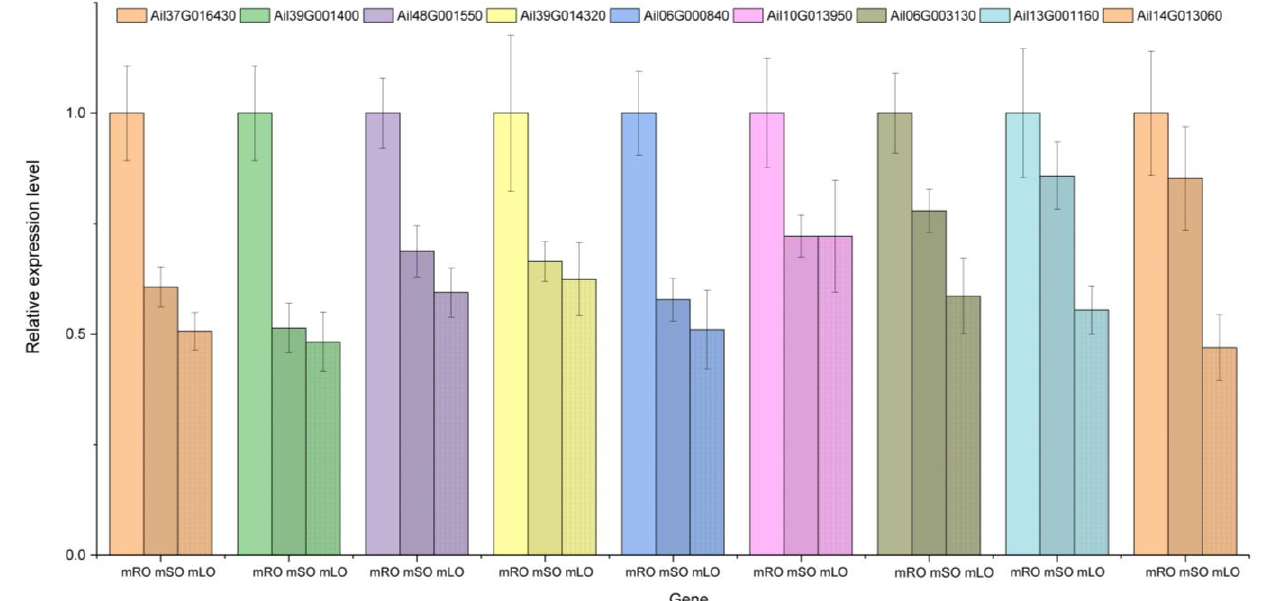
Figure 7. Expression levels of the candidate genes. The diagram distinguishes the nine genes with different colors. mOR, mOS, and mOL represent mature roots, mature stems, and mature leaves, respectively.